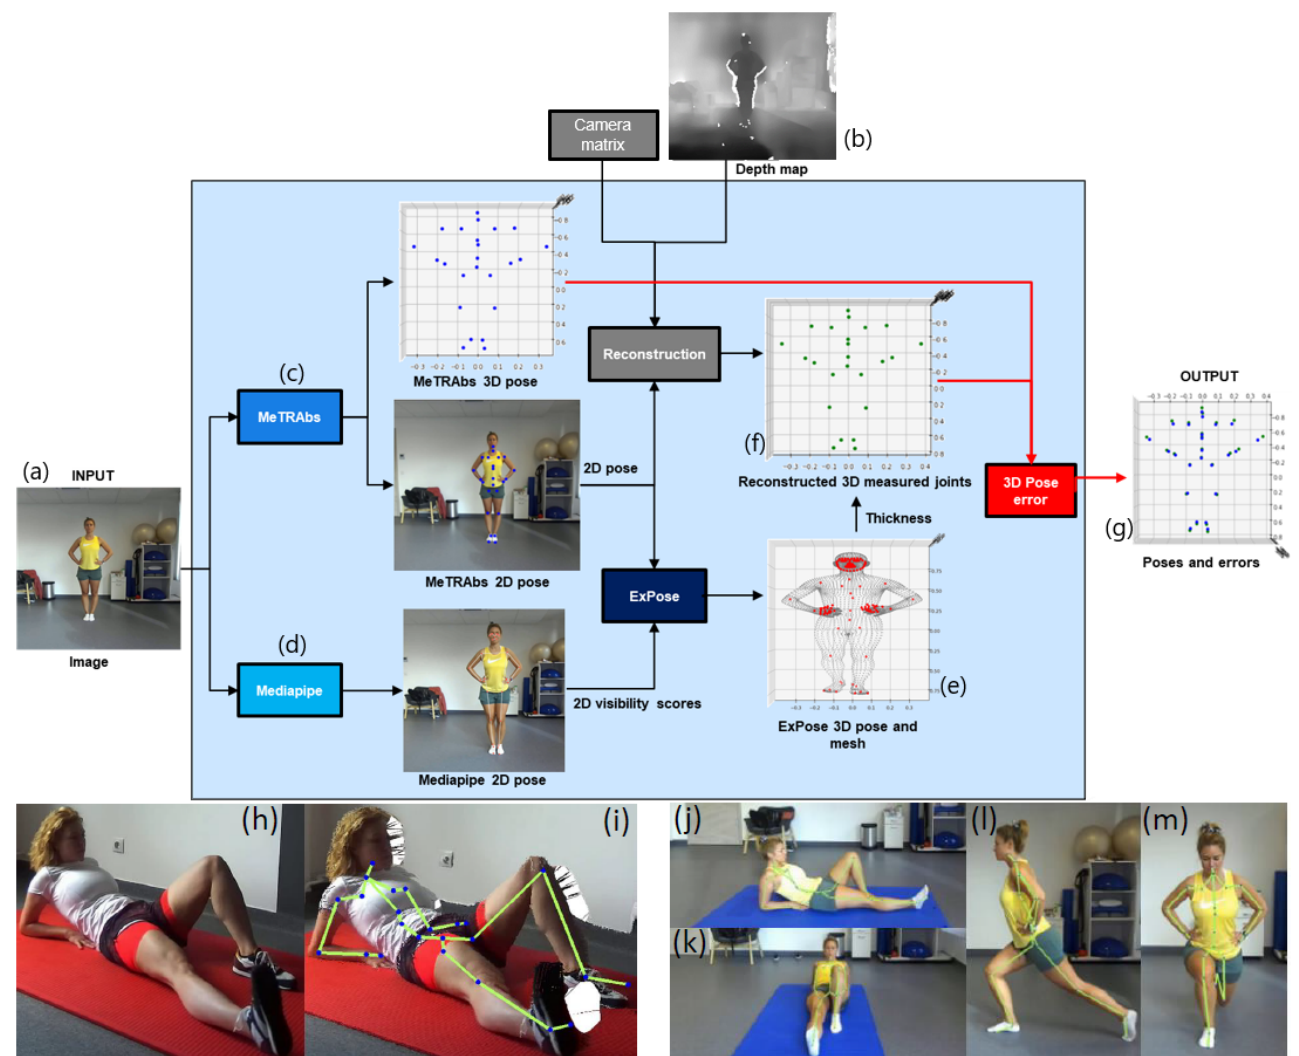
Figure 2. Body Pose module. ( a ) RGB input, ( b ) depth input, ( c , d ) 3D skeleton points estimated by MeTRAbs and MediaPipe, ( e ) ExPose 3D surface point estimation, ( f ) joint points estimation using Zed2 data and ExPose surface points, ( g ) joint error estimation, ( h ) large perspective distortions, ( i ) corrected image appropriate for skeleton estimation, ( j – m ) frames from two movements from two angles having error estimations. Best viewed by zooming in. For more details, see Section